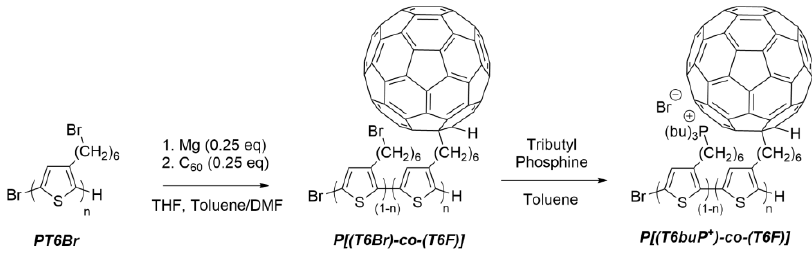
Table 1. Polymers ’